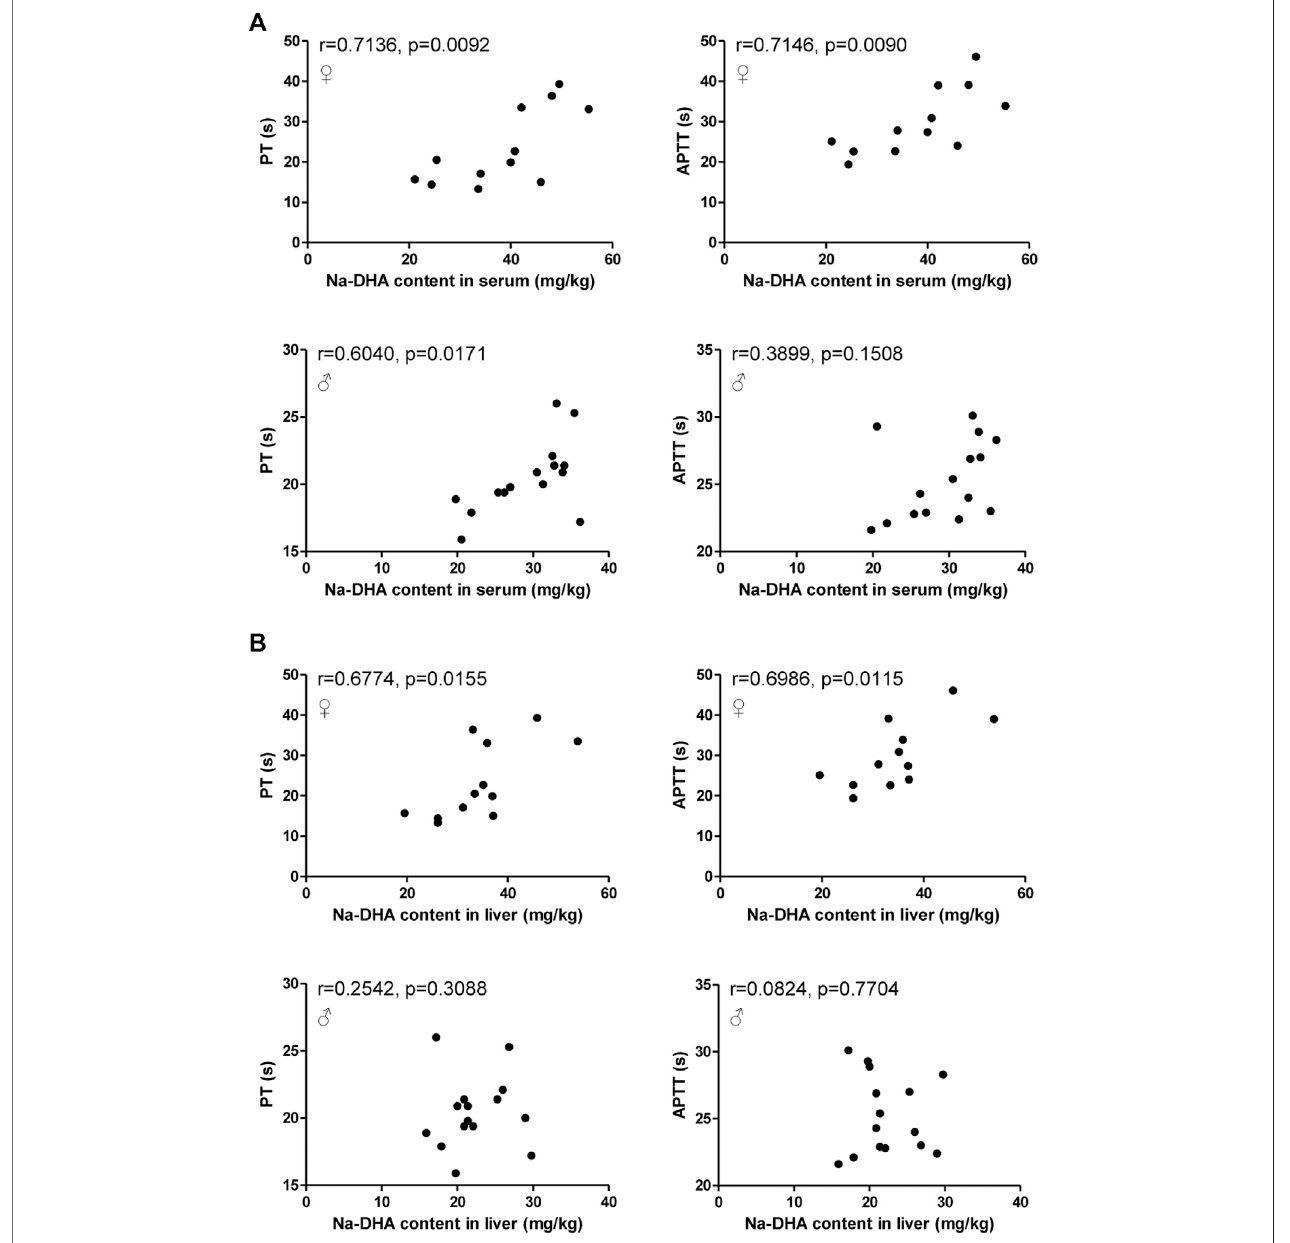
FIGURE4| CorrelationanalysisofNa-DHAcontentinthebloodandliverwithPT/APTT.ThePT/APTTof fi veratsadministered200mg/kgNa-DHAweremeasured by acoagulation analyzer; theNa-DHAcontent in theserum and liver ofthree rats were measured bythe HPLC method; (A) the correlation analysis ofPT/APTT with the serum concentration inmale orfemale rats; (B) thecorrelation analysisofPT/APTTwith theNa-DHA concentrationinthe femaleliver. Pearson correlation wasanalyzed. Data were obtained from triplet repeat experiments.